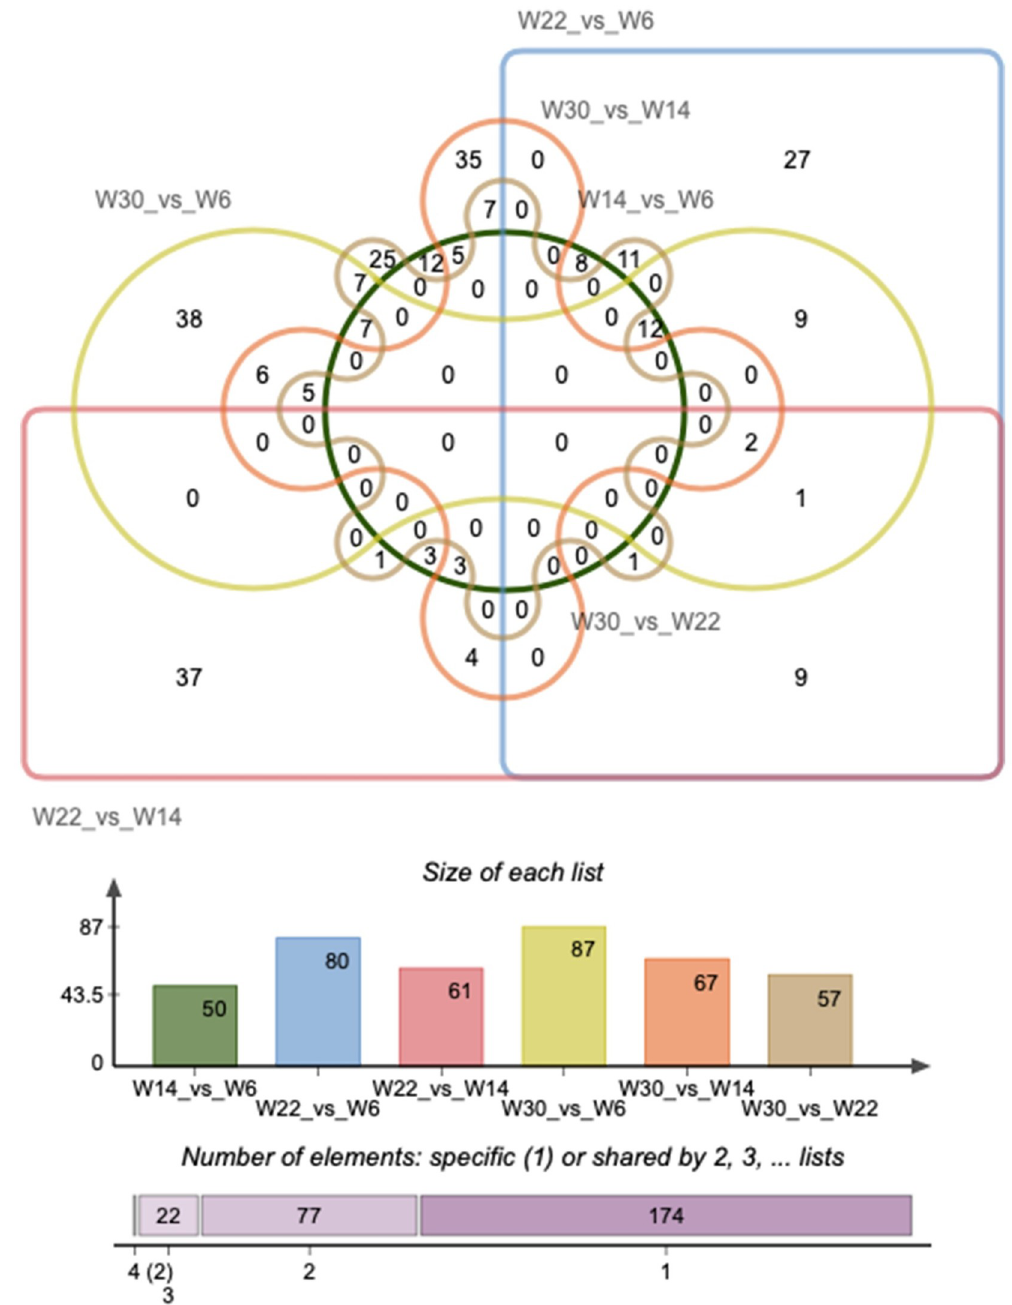
Fig 3. Venn diagram of the DE circRNAs in six comparison